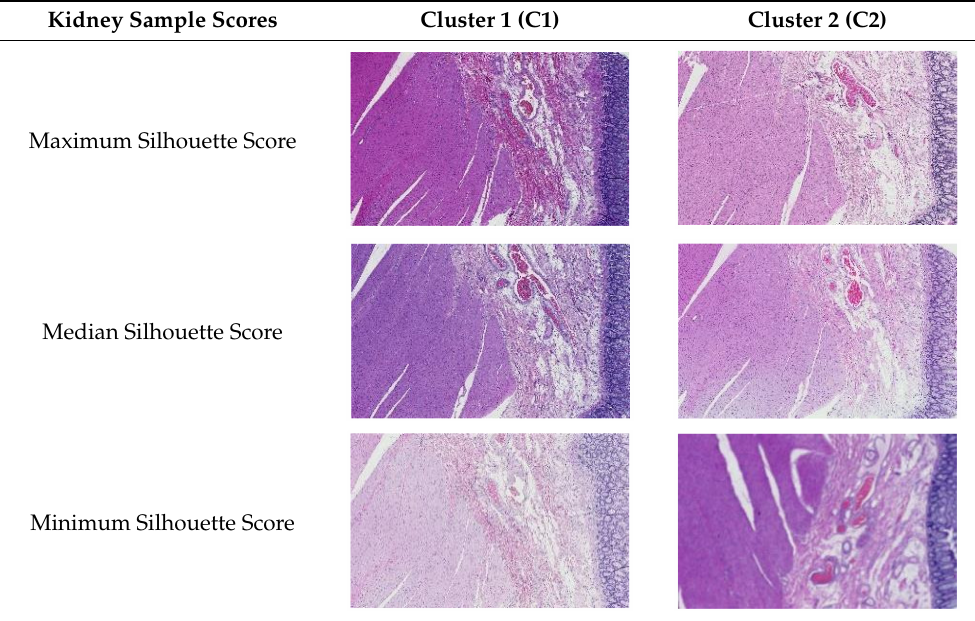
Table 5. Visualized ranks from silhouette score for the colon sample’s two found clusters (C1 and C2).